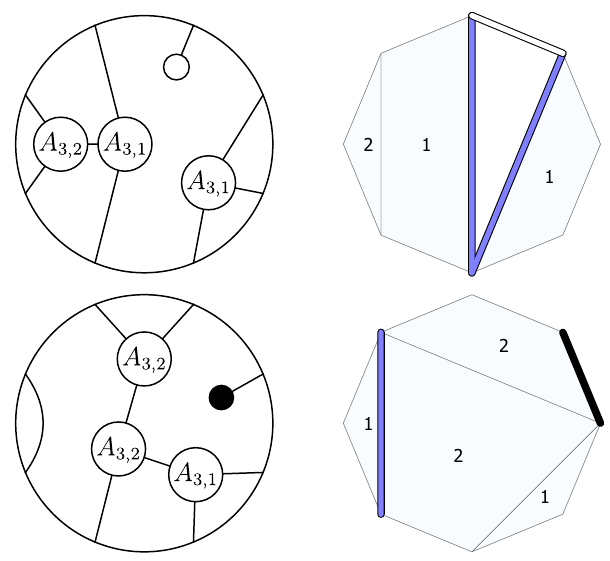
Figure 7 . Dual diagrammatic labels for boundaries of the momentum